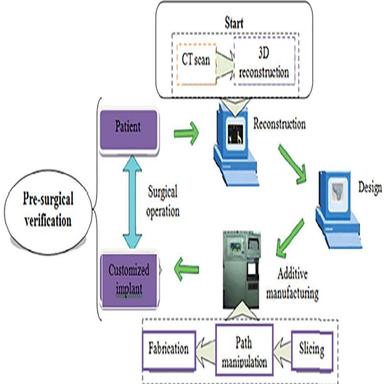
Schematic diagram of additive manufacturing in customization of biomedical parts .